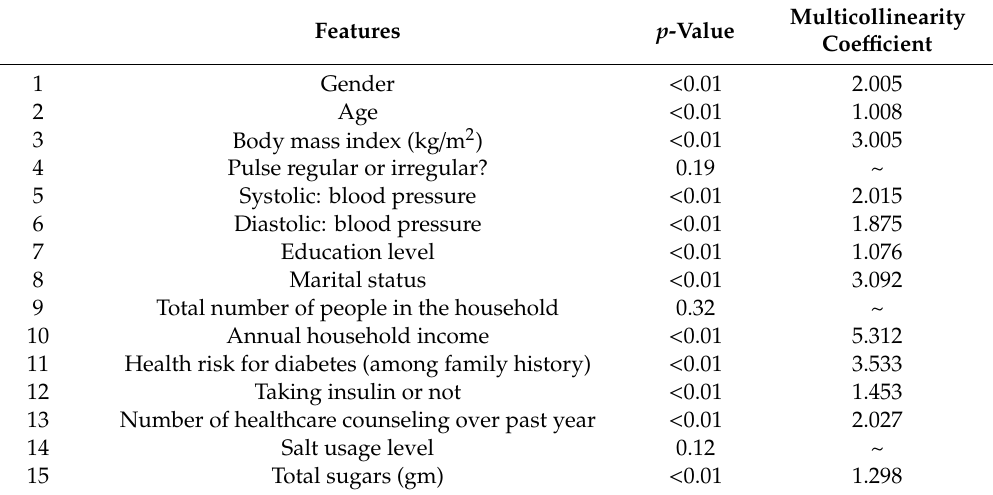
Table A3. Bivariate and Multicollinearity analysis for NHANES